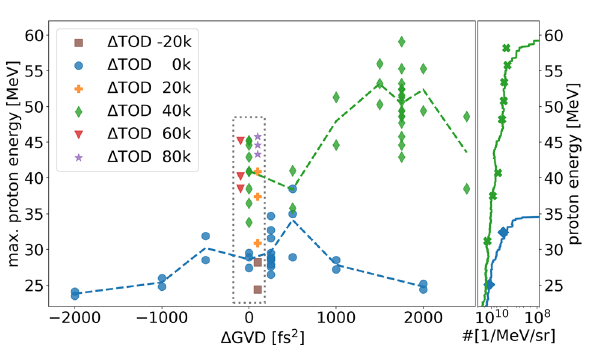
Figure 2. Temporal laser pulse shapes retrieved from SPIDER measurements for different spectral phase configurations (left: after automatic Dazzler Feedback-loop, right: manual phase manipulation (cid:31) GVD 1750 fs (cid:31) TOD 40k fs 3 ). While different laser energy configurations (diagnostic mode—solid blue, power mode— dashed red, power mode & PM—dotted green) show consistent pulse shapes, the two spectral phase settings significantly differ between an almost ideally compressed FTL pulse (dash-dotted grey) and an asymmetrical, slightly longer pulse with shallow rising edge and shifted pre- and postpuls distribution.